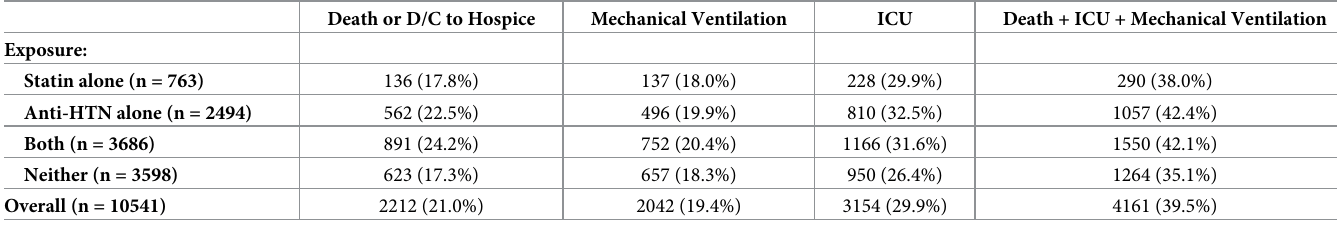
Table 2. Outcomes by statin and anti-hypertensive medication